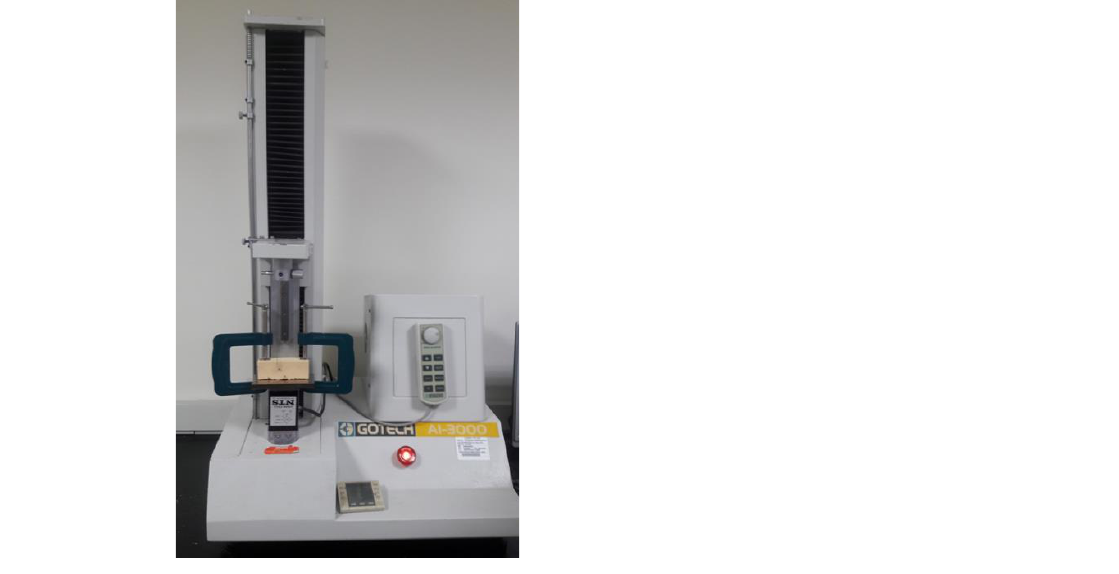
Table 1. The parameters of